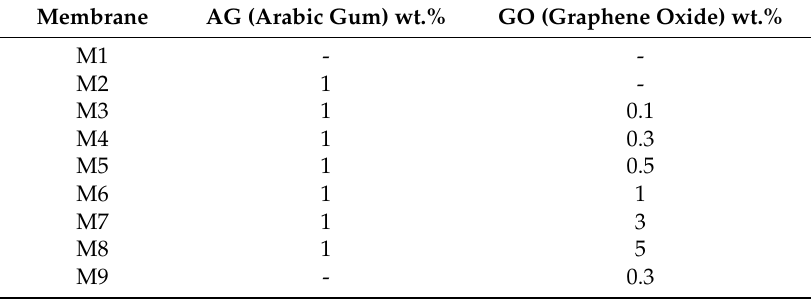
Table 1. Composition of PES (polyethersulfone) membranes synthesized. M1 is the neat membrane. All membranes were composed of 16% PES dissolved in DMA (N,N-Dimethylacetamide)